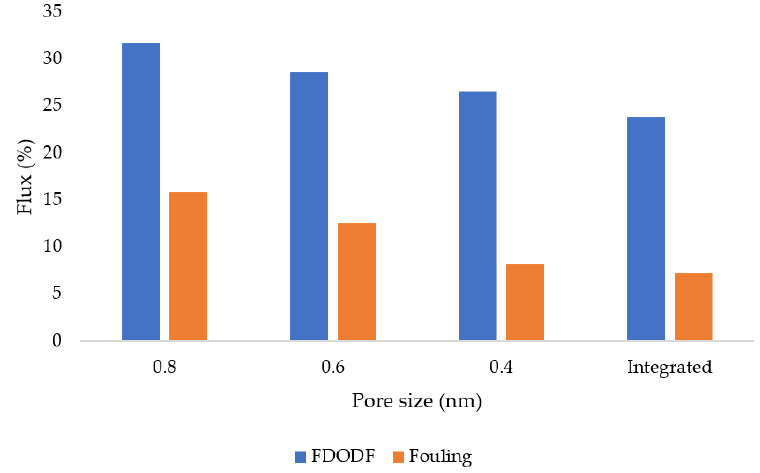
Figure 8. Flux decline occurred during filtration and fouling. FDODF = flux decline occurring during filtration.